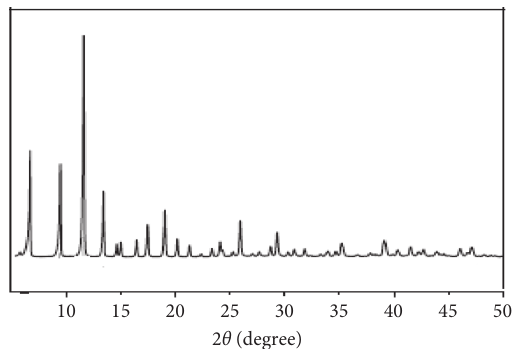
Figure 4: XRD pattern of CuBTC-monopol